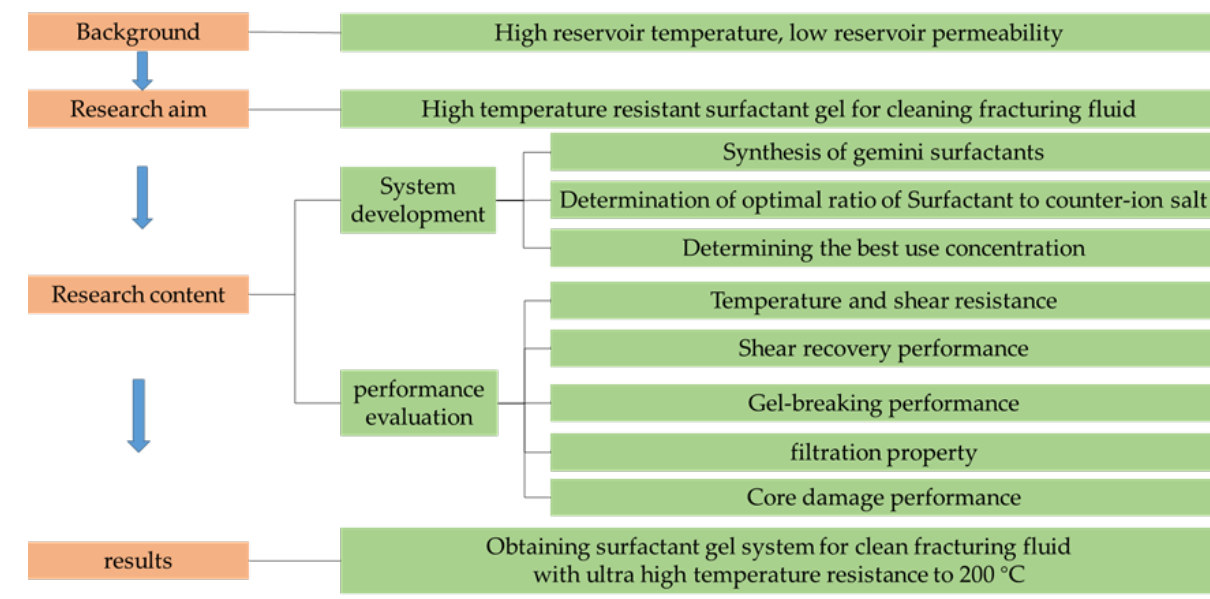
Figure 2. Research flow chart.